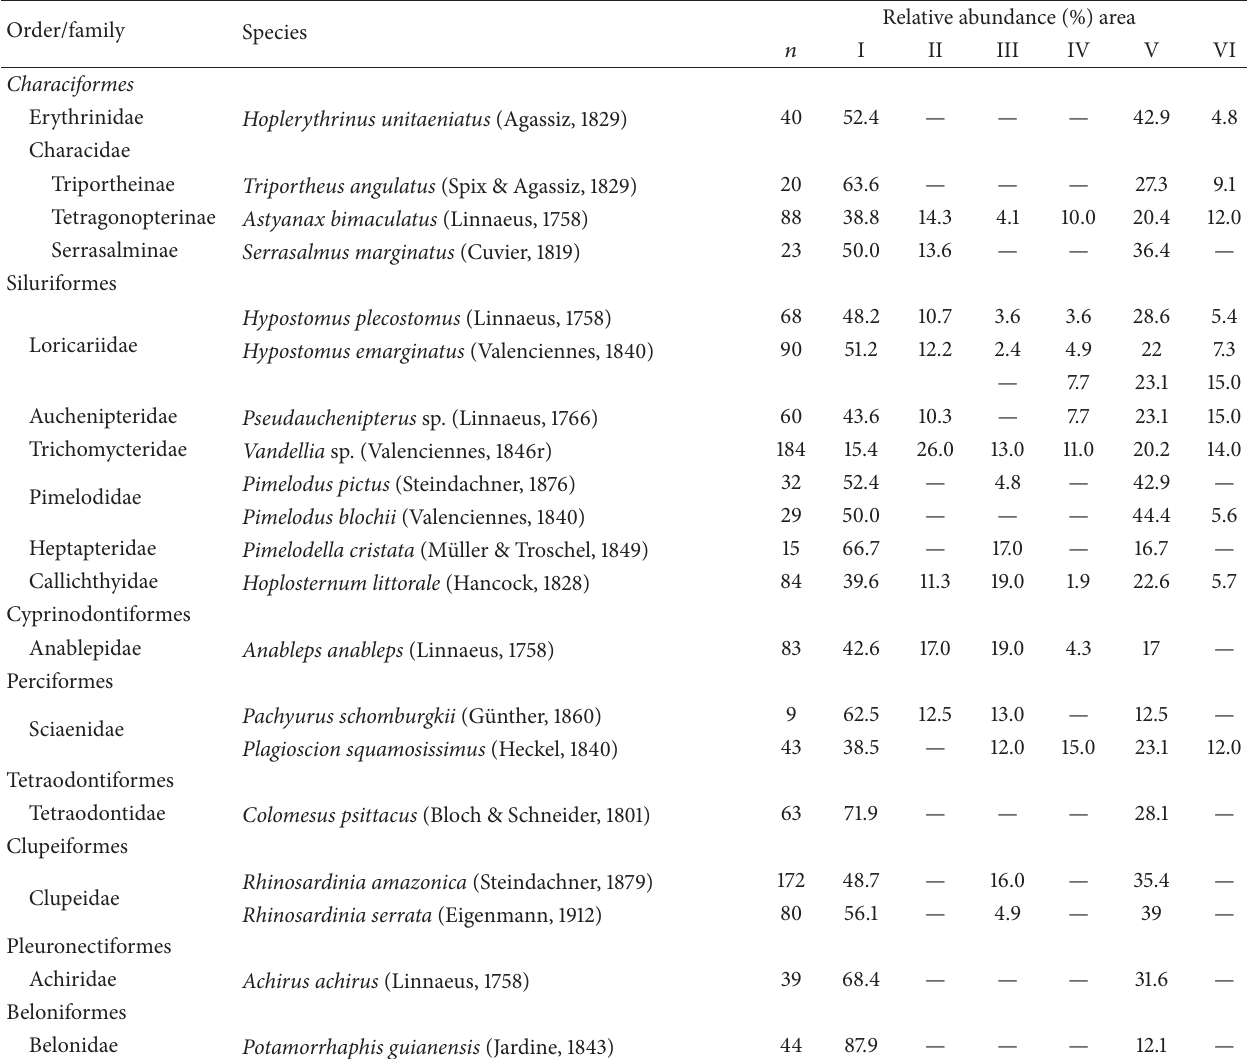
Table 2: Occurrence and relative abundance of fish species recorded in the intertidal zone of an urban waterfront on the Amazon. Order/family Species